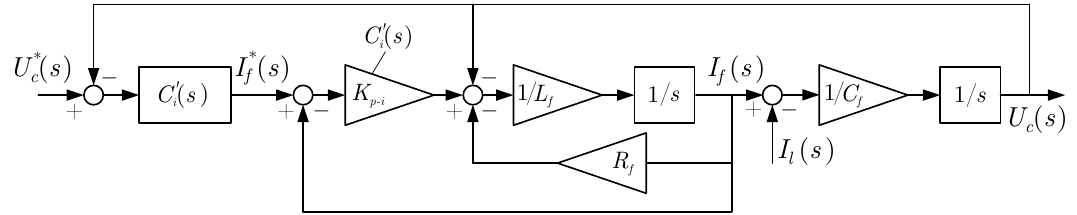
Figure 19. Simplified block diagram of a DVR with a cascade